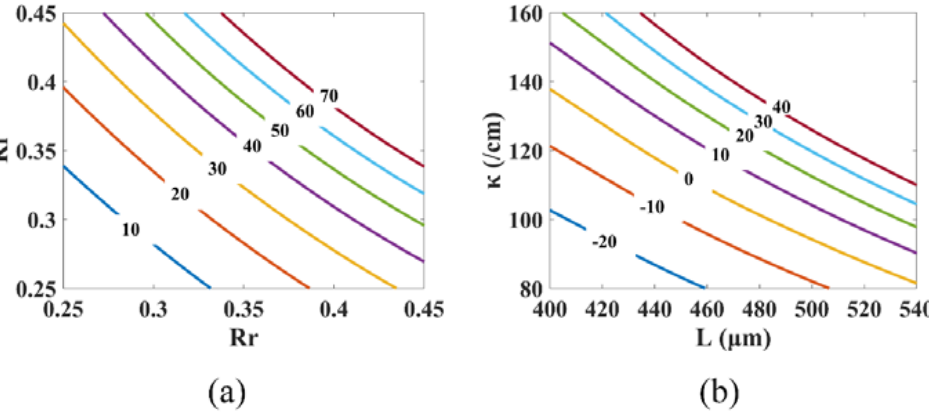
Figure 5. The PPR shape factor dependence on parameters with P bias = 12 mW: ( a ) PPR shape factor vs. R f and R r with L = 450 µ m and κ = 100/cm; ( b ) PPR shape factor vs. L and κ with R f = R r = 0.2 .